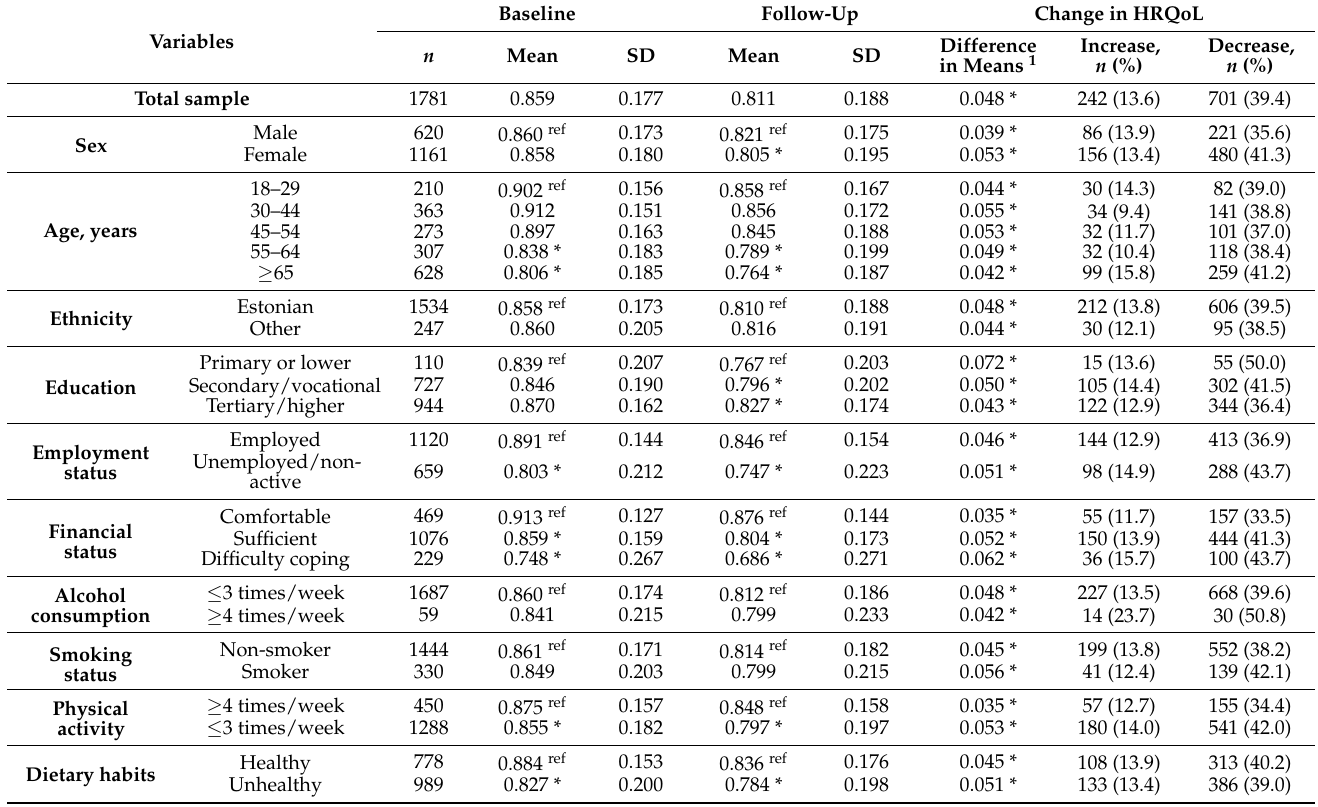
Table 2. EQ-5D-3L index scores at baseline and follow-up by sample characteristic and changes in HRQoL, Estonia